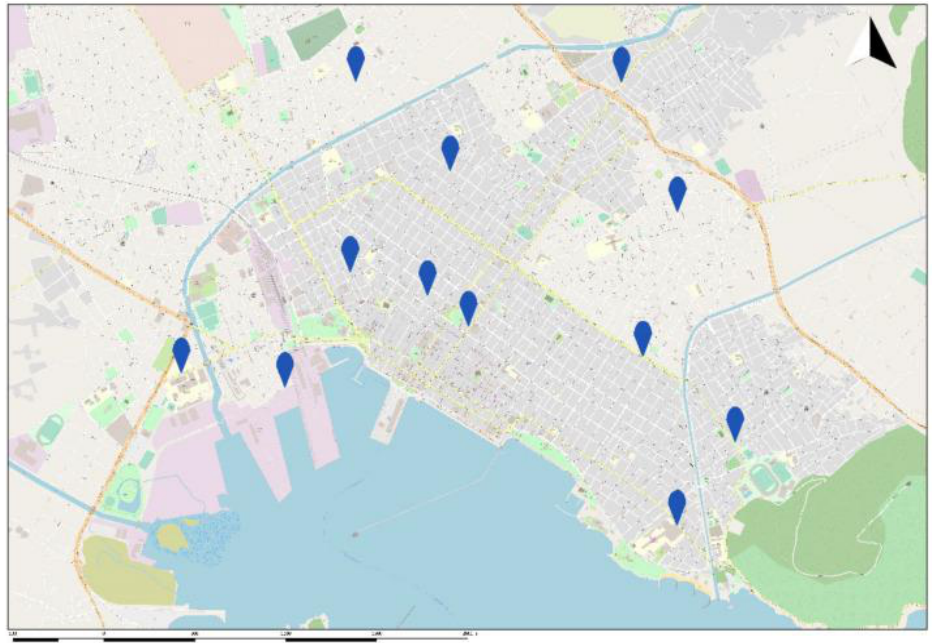
Figure 1. Map of the city of Volos presenting the location of sensors. Markers indicate the location of the sensors.